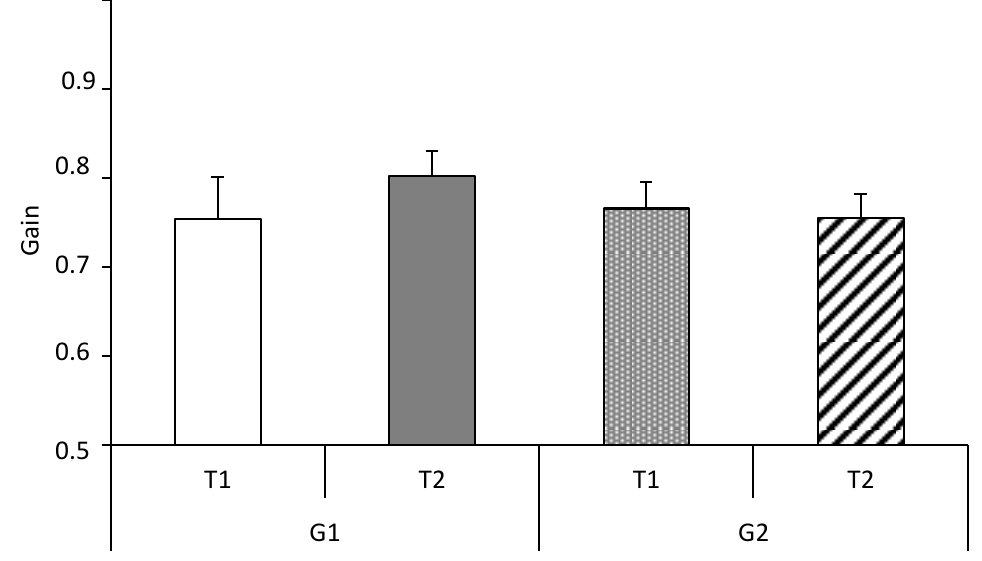
Figure 4. Pursuit gain values tested at T1 and T2 for the two groups of children with ADHD ( G1 : interventional group and G2 : non-interventional